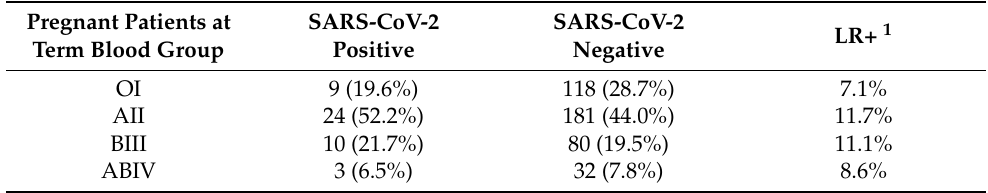
Table 2. Number and percentage of different blood groups in the SARS-CoV-2 positive and negative pregnant patients at